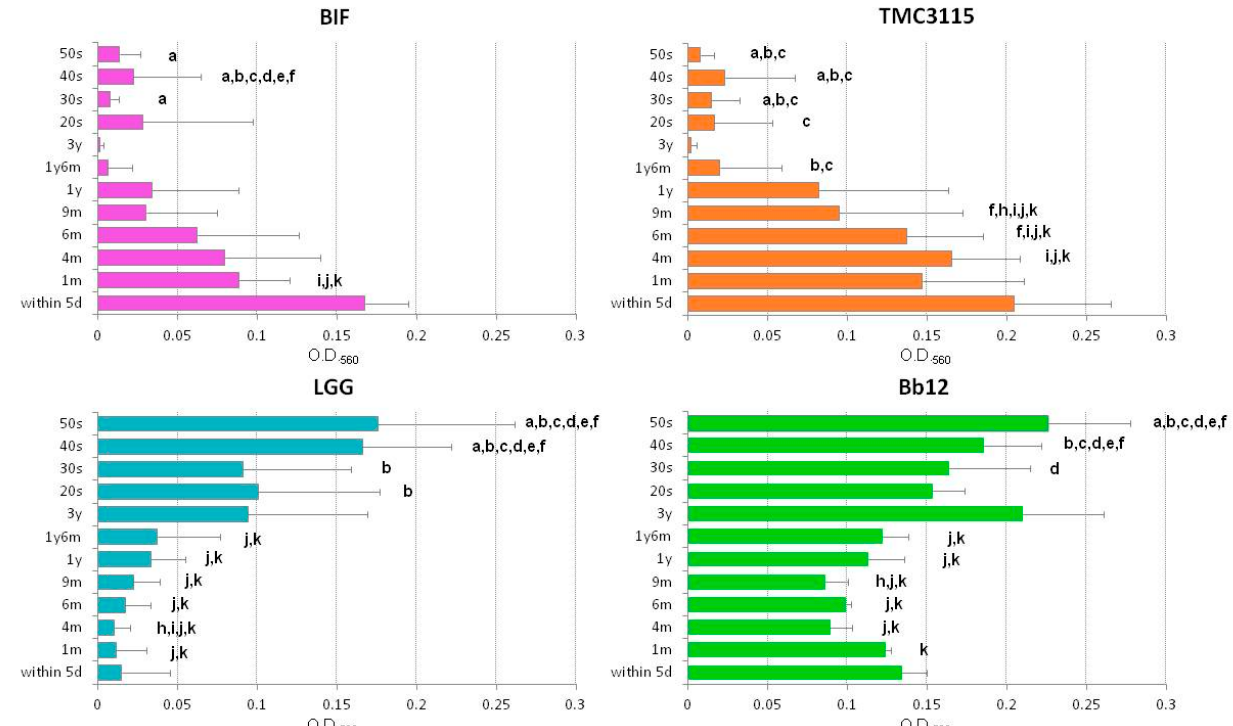
Figure 3. Age/generation-dependent adhesion properties of four highly human mucus adhesive strains. Data are expressed as the mean ± SE, and differences between means were tested for significance using a one-way ANOVA followed by the Kruskal–Wallis and Steel–Dwass tests. a,b,c,d,e,f,g,h,i,j,k Significantly different ( p < 0.05) to adhesion to mucus from a 1m, b 4m,